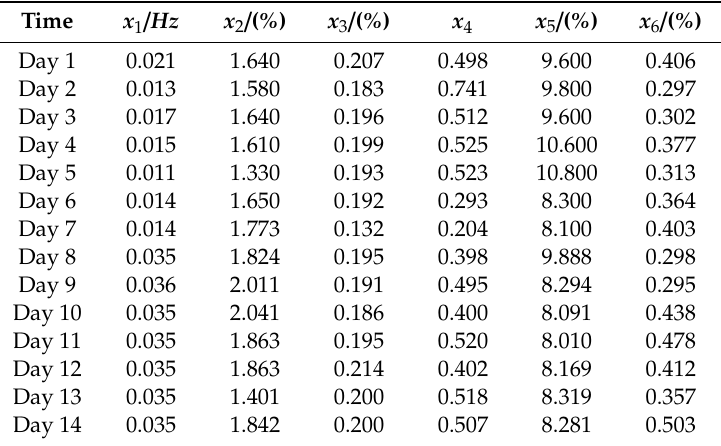
Table 5. Deviation values of measured data.